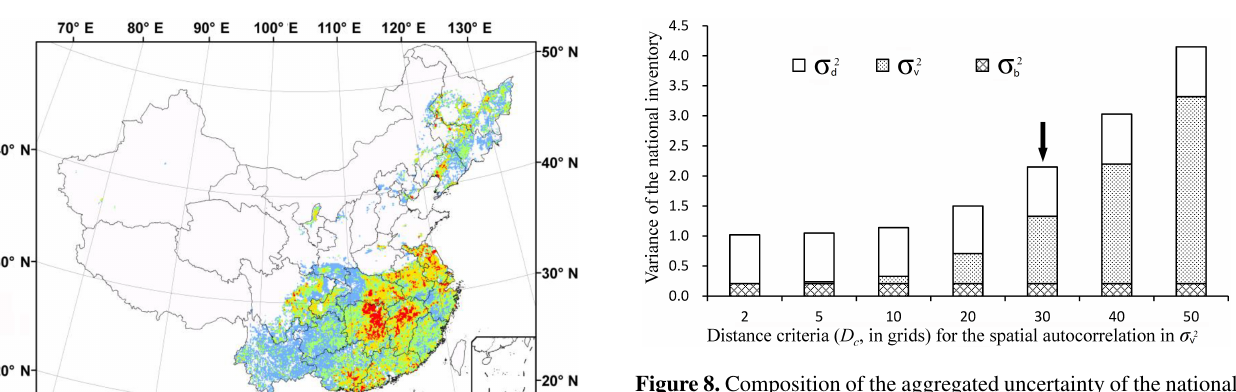
Figure 8. Composition of the aggregated uncertainty of the national inventory along with the spatial autocorrelation of the variances of the model residues in grids. Distance criteria ( D c ) are used to define the step functions of spatial autocorrelation: if two grids diverge by a distance beyond D c , the autocorrelation is 0; otherwise, it is 1. The step function is a simplified version and represents the upper limit of the true spatial autocorrelation. With the step function, a larger D c indicates stronger